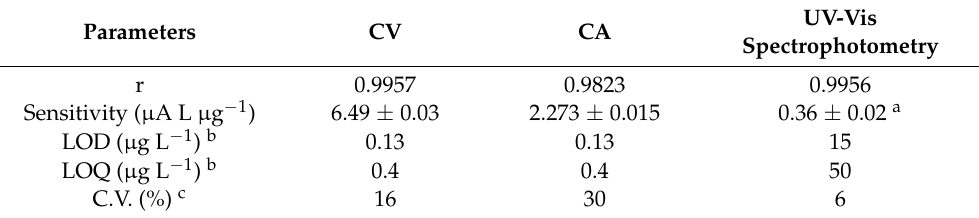
Table 1. Analytical figures of merit of the methods for MTU